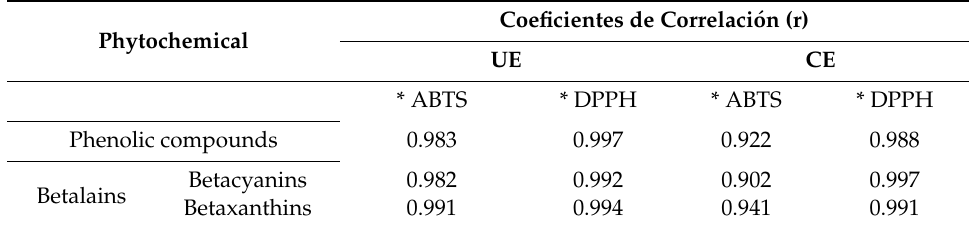
Table 4. Values of correlation coe ffi cients between antioxidant capacity (ABTS, DPPH) and the phytochemical content of the Uncleared extract and Clarified extract of pitaya ( Stenocereus thurberi